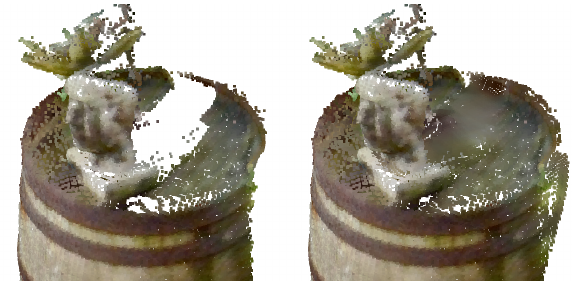
Figure 5. Inpainting the Backyard segment. Even though the Figure 7. An example of a large occlusion hole surrounded by input data (left) is of low quality, a plausible surface can be poorly sampled colors in the Backyard segment. The colors of inferred in the output (right) point cloud. the input (left) are smoothly interpolated in the inpainting result (right). The bust visible in the image was processed separately. Points in the background have been removed for visual